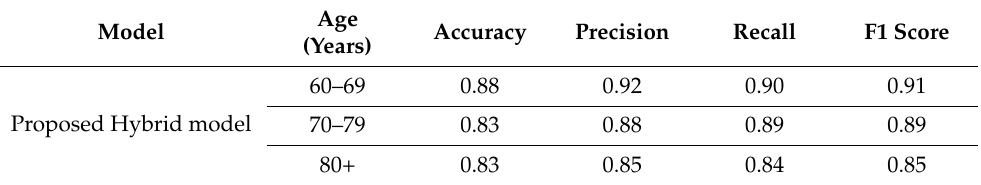
Table 5. Multi-class performance evaluation table of the improved LeNet model. Model